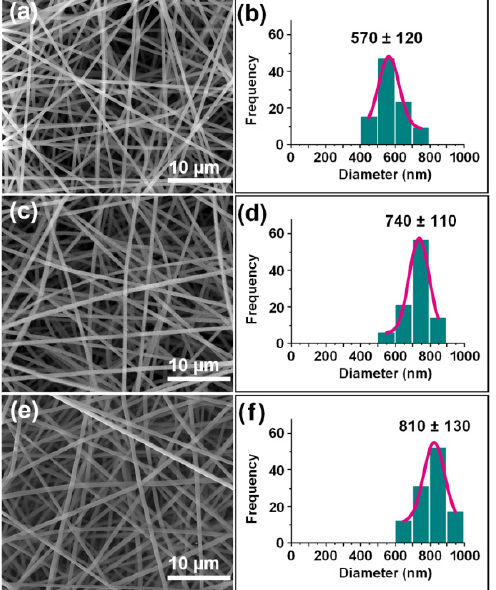
Figure 2. Field emission scanning electron microscope (FESEM) images of the electrospun nanofibres and their diameter distributions: ( a and b ) F1; ( c and d ) F2; ( e and f )